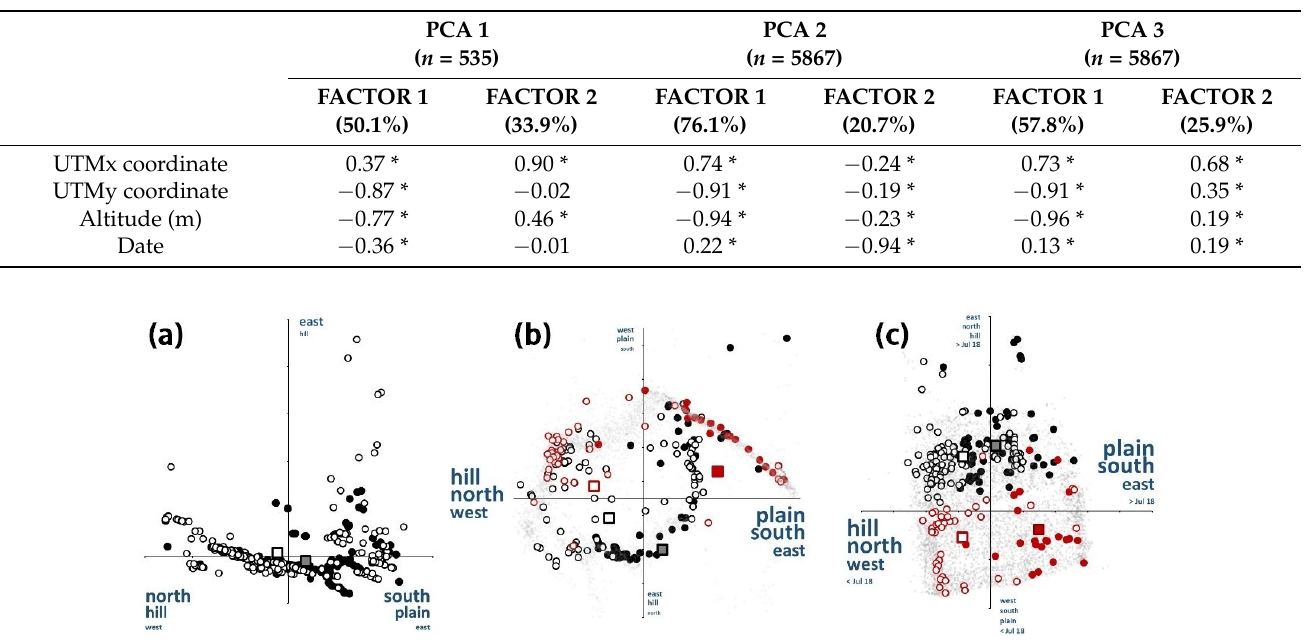
Table 4. Pearson correlations between the three main factors of a three principal component analysis (PCA) applied to a matrix of locations × UTM coordinates, altitude, and eventually, date, where Iberian hare ( Lepus granatensis ) and rabbit ( Oryctolagus cuniculus ) could be registered from a Mediterranean agricultural area in S. Spain. PCA 1: the rows are records of Iberian hare and rabbit made between 1995 and 2019, while the columns give the X and Y coordinates, and the altitude (m) of each record. PCA 2: locations × UTM coordinates and altitude visited between December 2016 and March 2020. PCA 3: the same as previously, but including the date as a new variable. All the varia- bles were log-transformed. The date was also correlated with Factors 1 and 2 from PCA 1 and 2 to check whether theses gradients were also temporal. * p < 0.001.